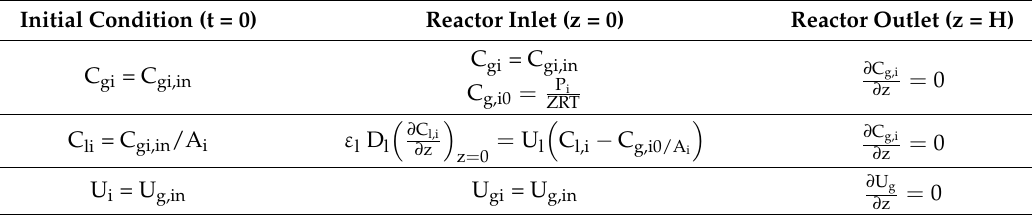
Table 3. Initial and boundary conditions for the slurry reactor